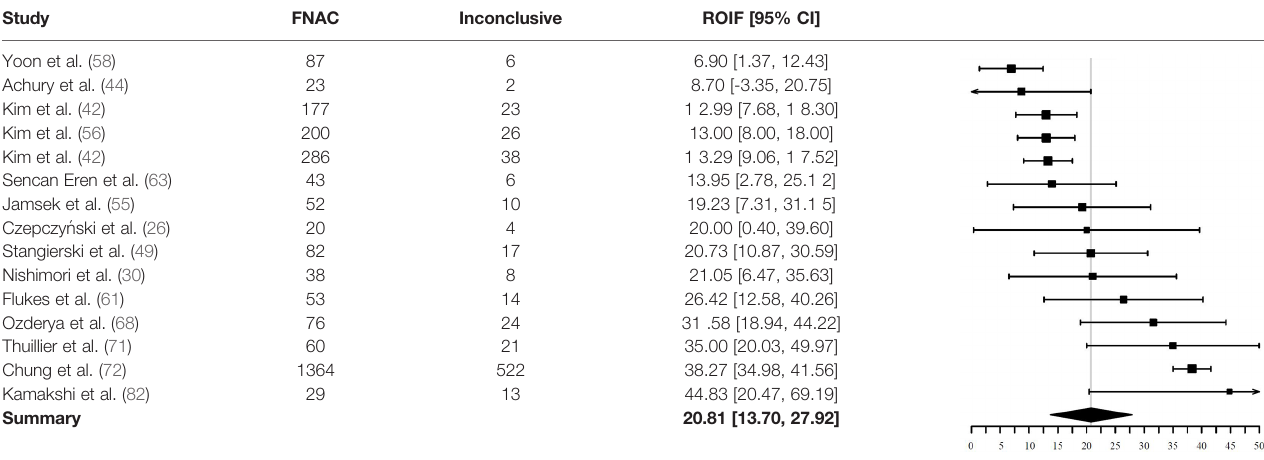
TABLE 5 | Risk of inconclusive FNAC of FTI (random effects, I 2 = 92%, symbol size re fl ects weight).